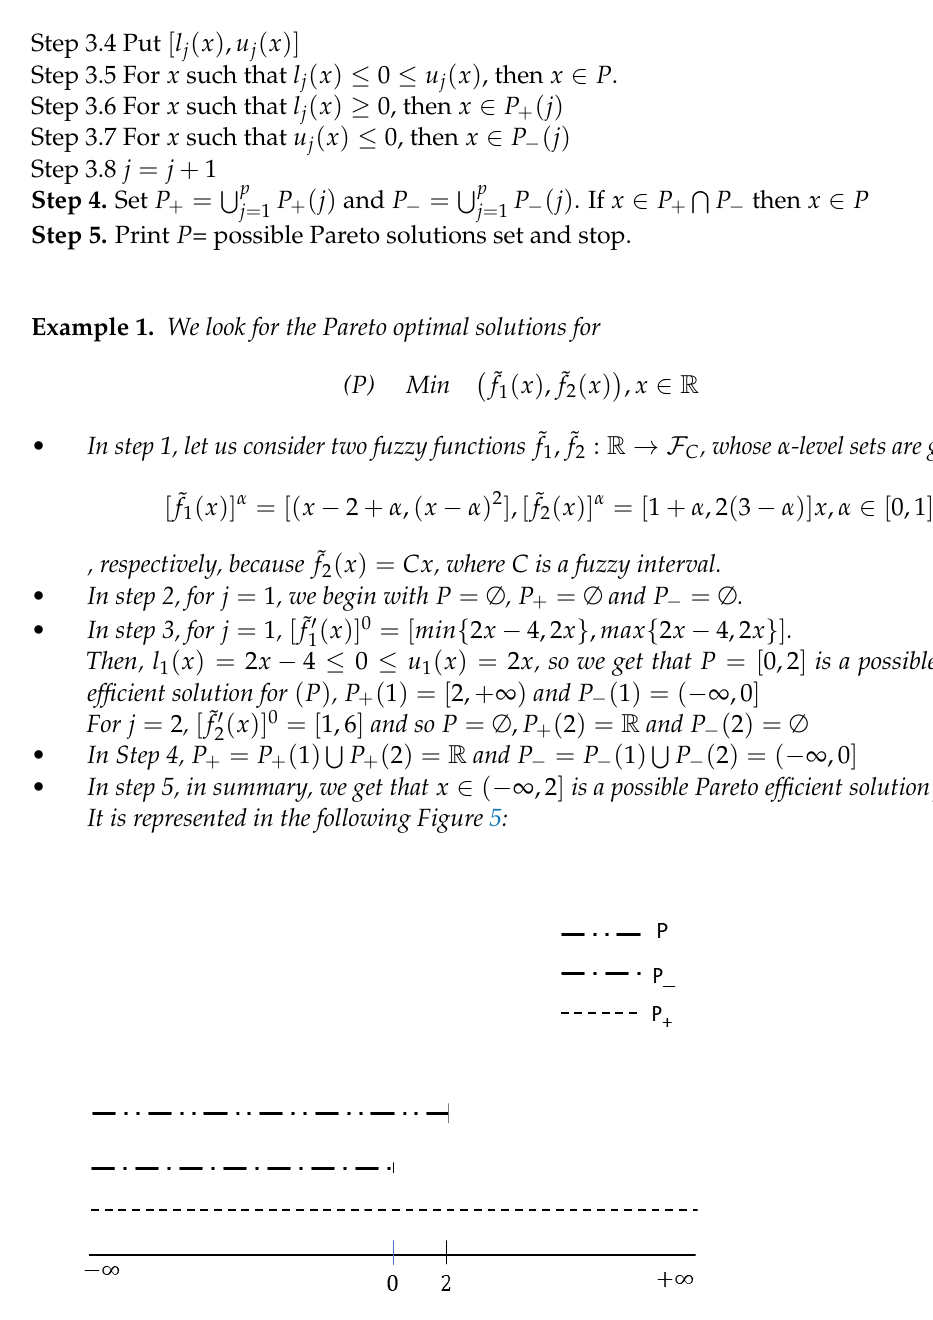
Figure 5. Pareto solutions